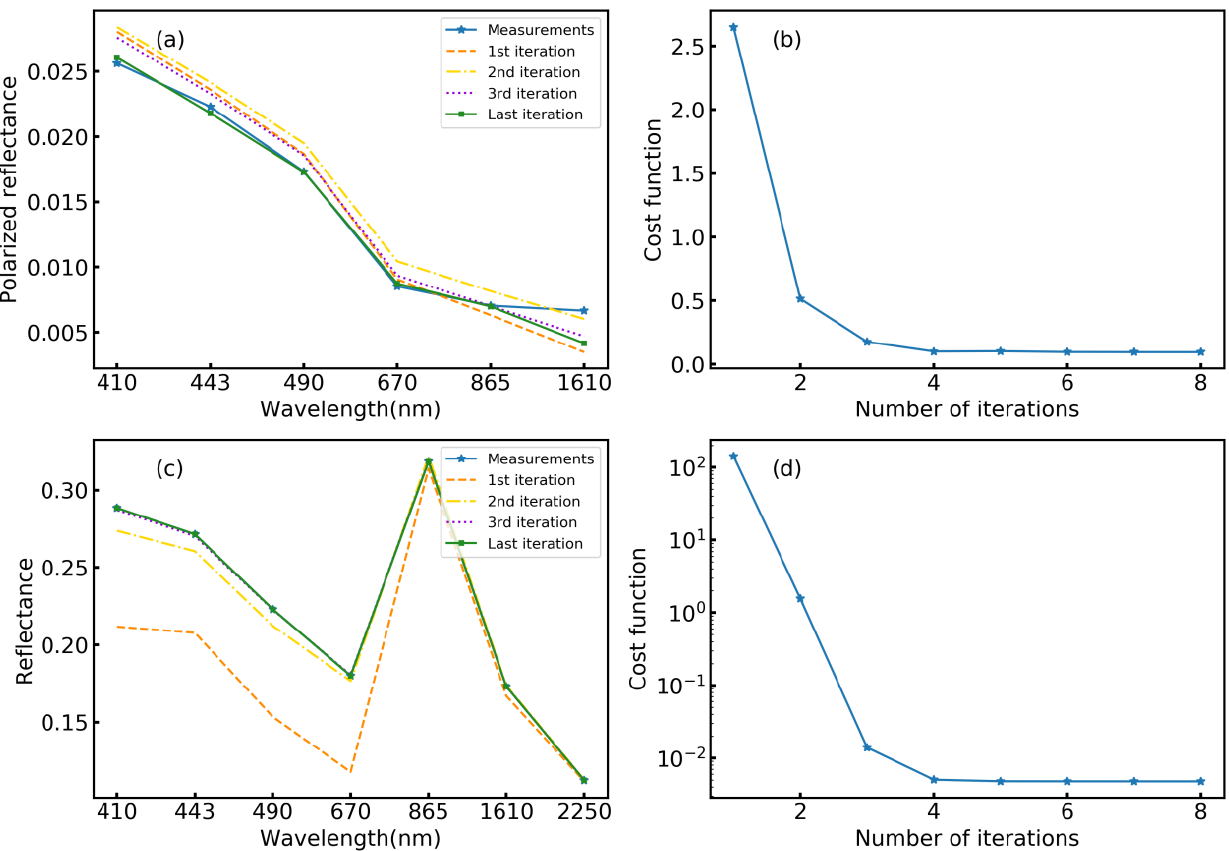
Figure 3. ( a , c ) Illustrations of the iterative process for TOA reflectance and TOA polarized reflectance, respectively. ( b , d ) The plot of the cost function as a function of iterations in polarization inversion and intensity inversion, respectively (case for 8 June 2022).